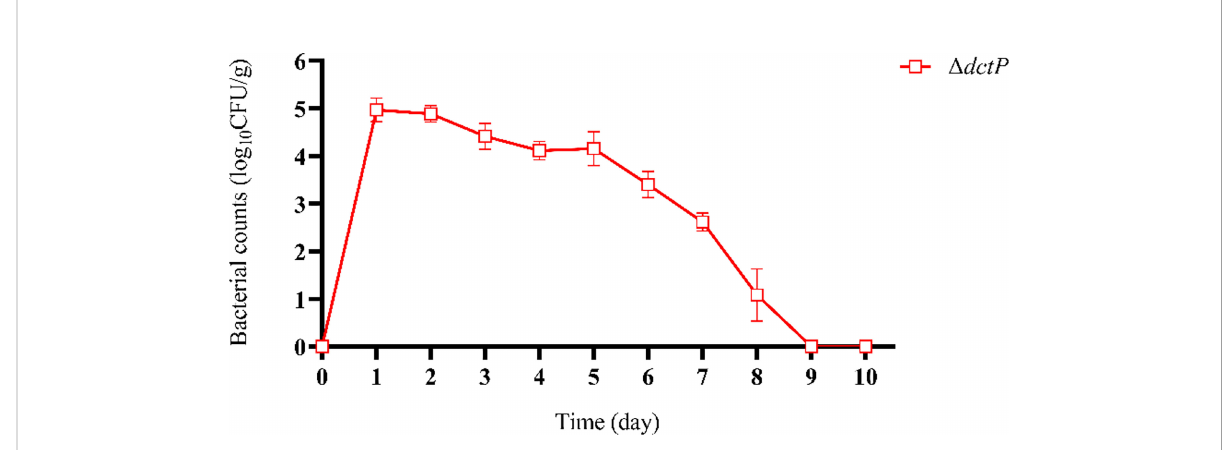
FIGURE 1 Pathogen load of liver, spleen, and head kidney mixture by D dctP strain. Values are means ± SEM (n =